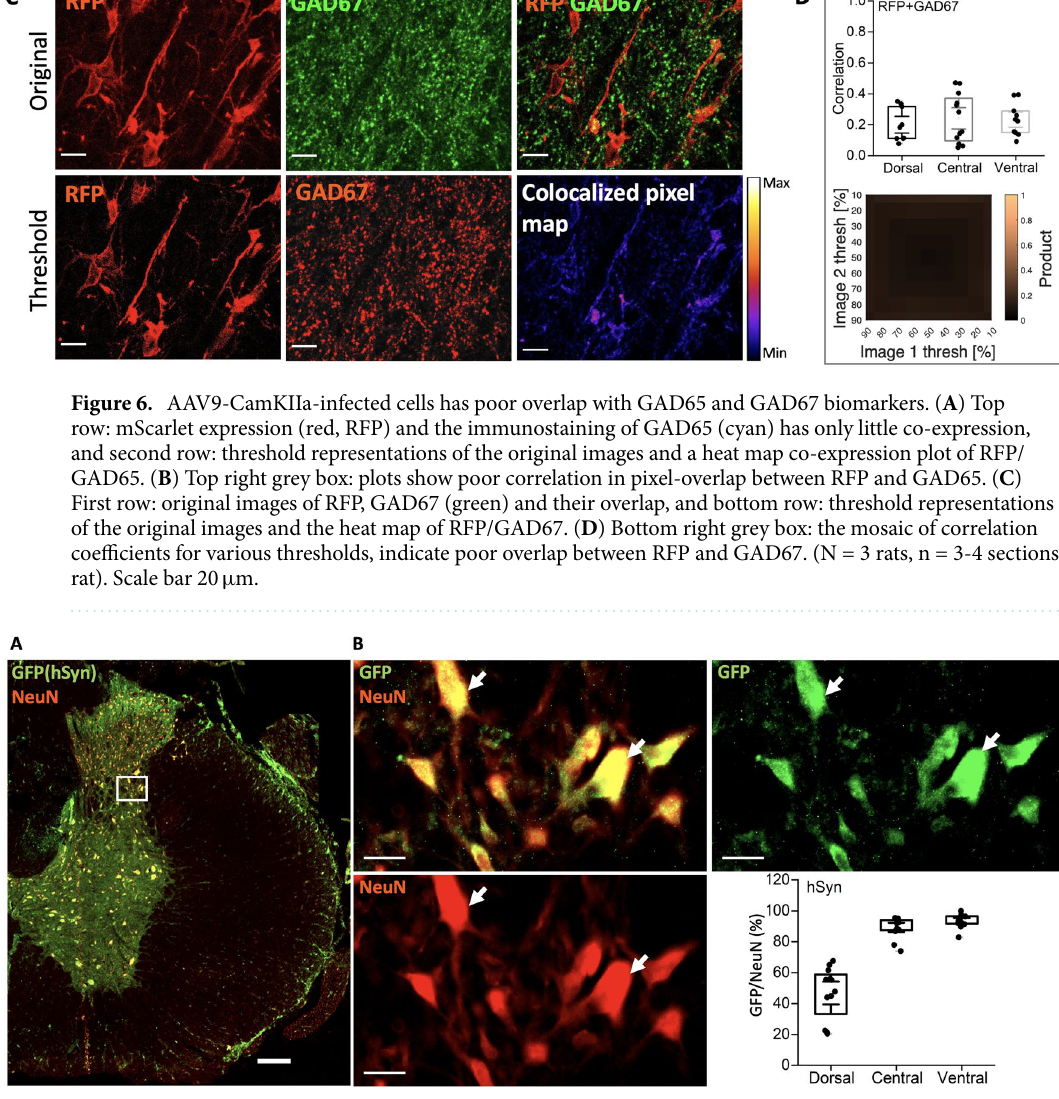
Figure 7. AAV9-hSyn1 targets a large fraction of spinal neurons. ( A ) A spinal section with infection using hSyn1-promoter co-stained with NeuN marker for neurons. ( B ) Highlighted region in ( A ) shows the extensive overlap between the infected cells and the NeuN marker and box plots at the bottom right show 40–60% co-expression of NeuN and GFP in the dorsal region whereas 90% overlap in the central and ventral regions. Scale bar = 200 µ m in image ( A ) and 20 µ m in the zoomed-in images ( B ). N = 4 animals, n = 3